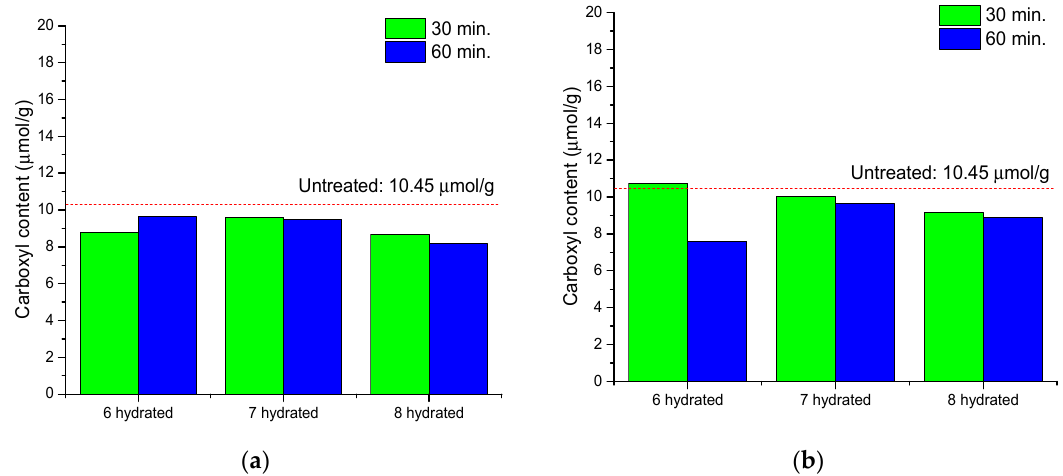
Figure 5. Carboxyl content of cellulose after dissolving as a function of the number of hydrates in calcium thiocyanate at 100 °C ( a ) and 120 °C ( b ).